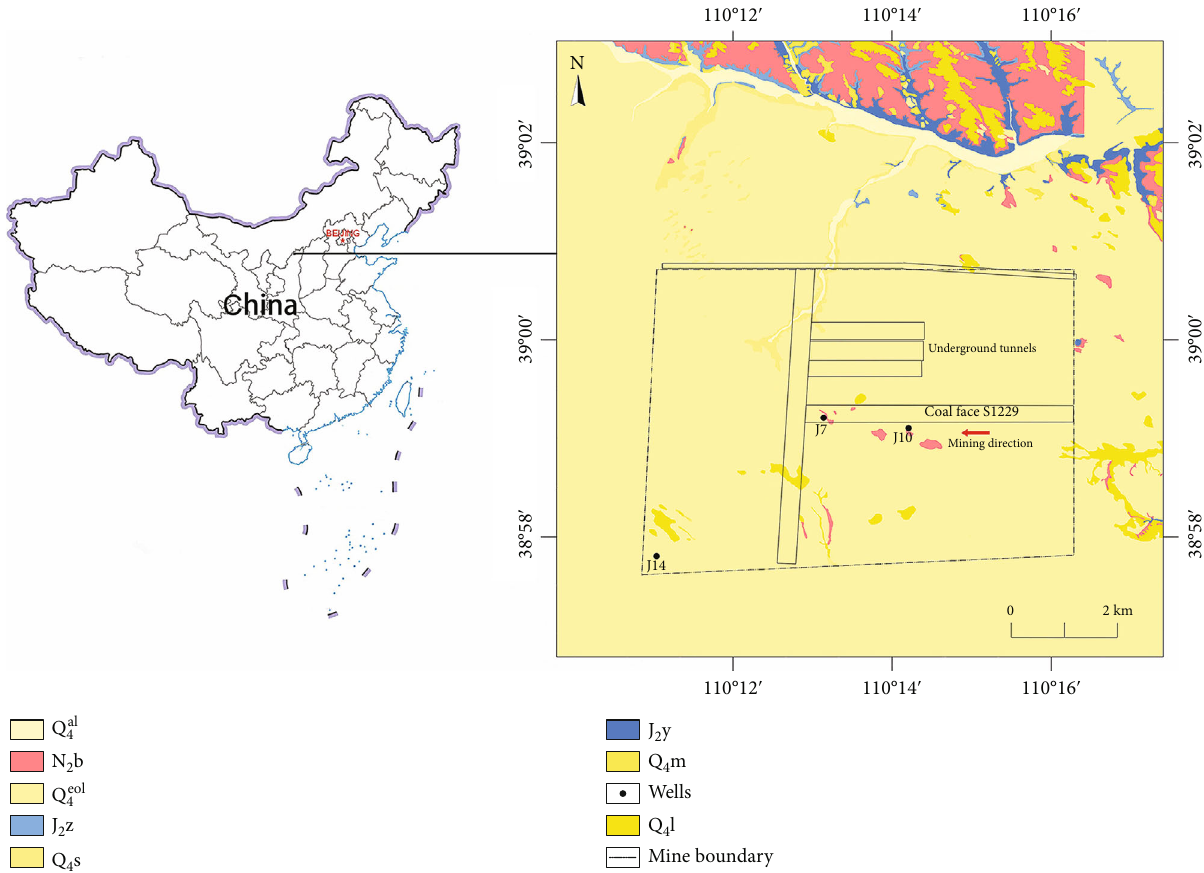
Figure 1: Geological map with location of longwall coal faces, boreholes of Ningtiaota Coal fi